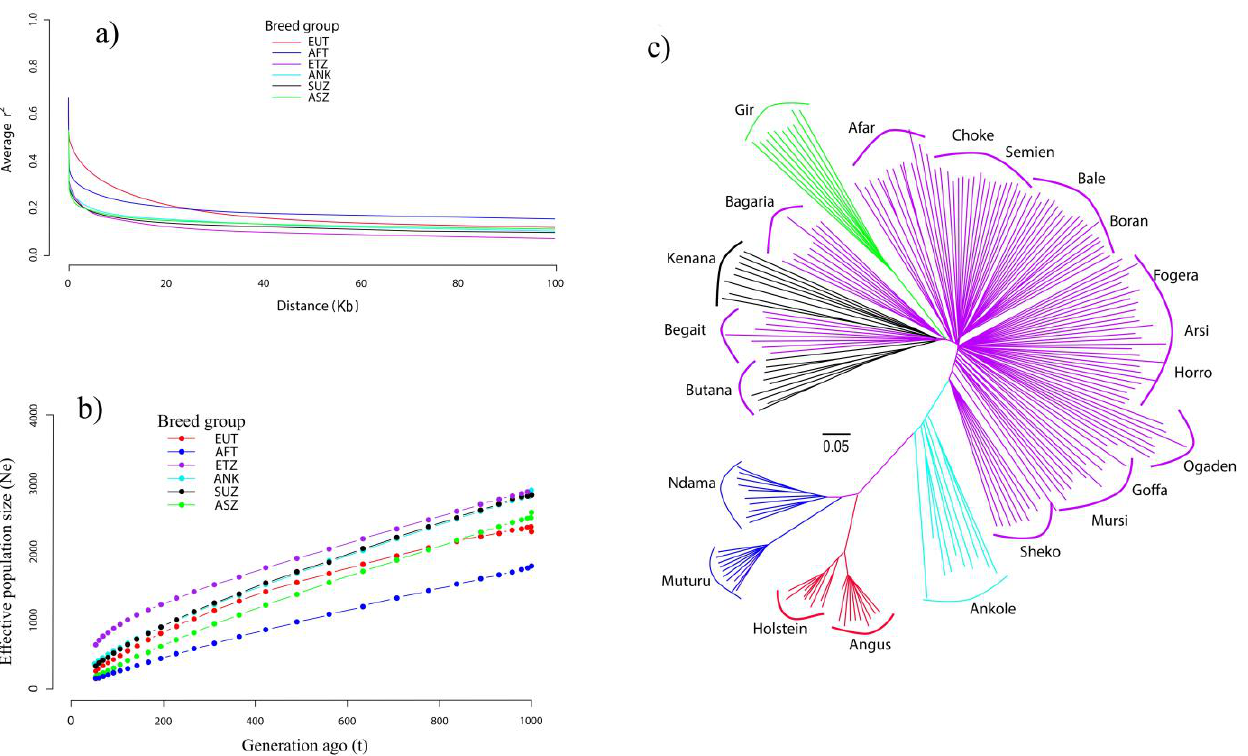
Figure 6. Genomic demography of Ethiopian and non-Ethiopian cattle populations. ( a ) LD decay, ( b ) Effective population size, and ( c ) Neighbor-joining tree for all Ethiopian and non-Ethiopian cattle. Red = European taurine (EUT), blue = African taurine (AFT), cyan = Ankole, green = Asian zebu (ASZ), black = Sudanese zebu (SUZ), and purple = Ethiopian zebu (ETZ).